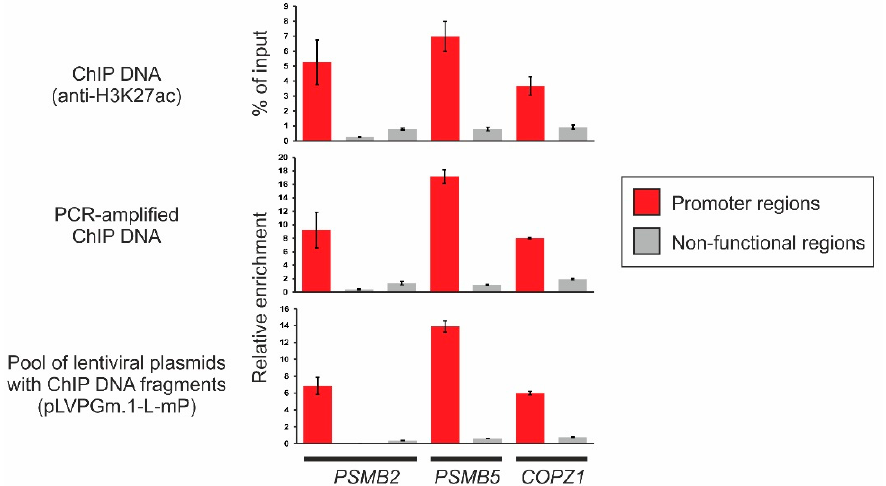
Figure 2. Analysis of the enrichment of ChIP DNA with functional elements using the promoter regions of the housekeeping genes PSMB2 , PSMB5, and COPZ1 . Initial ChIP DNA was immunoprecipitated from MIA PaCa-2 cells using antibodies to H3K27ac, ligated with adapters, amplified by PCR, and cloned to lentiviral plasmid pLVPGm.1-mP in E. coli cells. ~20 × 10 6 clones were received, and a pool of lentiviral plasmids with inserts was isolated. Content of promoter regions of PSMB2 , PSMB5, and COPZ1 genes (red columns), as well as non-functional regions (gray columns), was determined in initial, amplified, or cloned in lentivirus ChIP DNA by qPCR. Mean of three experiments and standard deviation are presented.